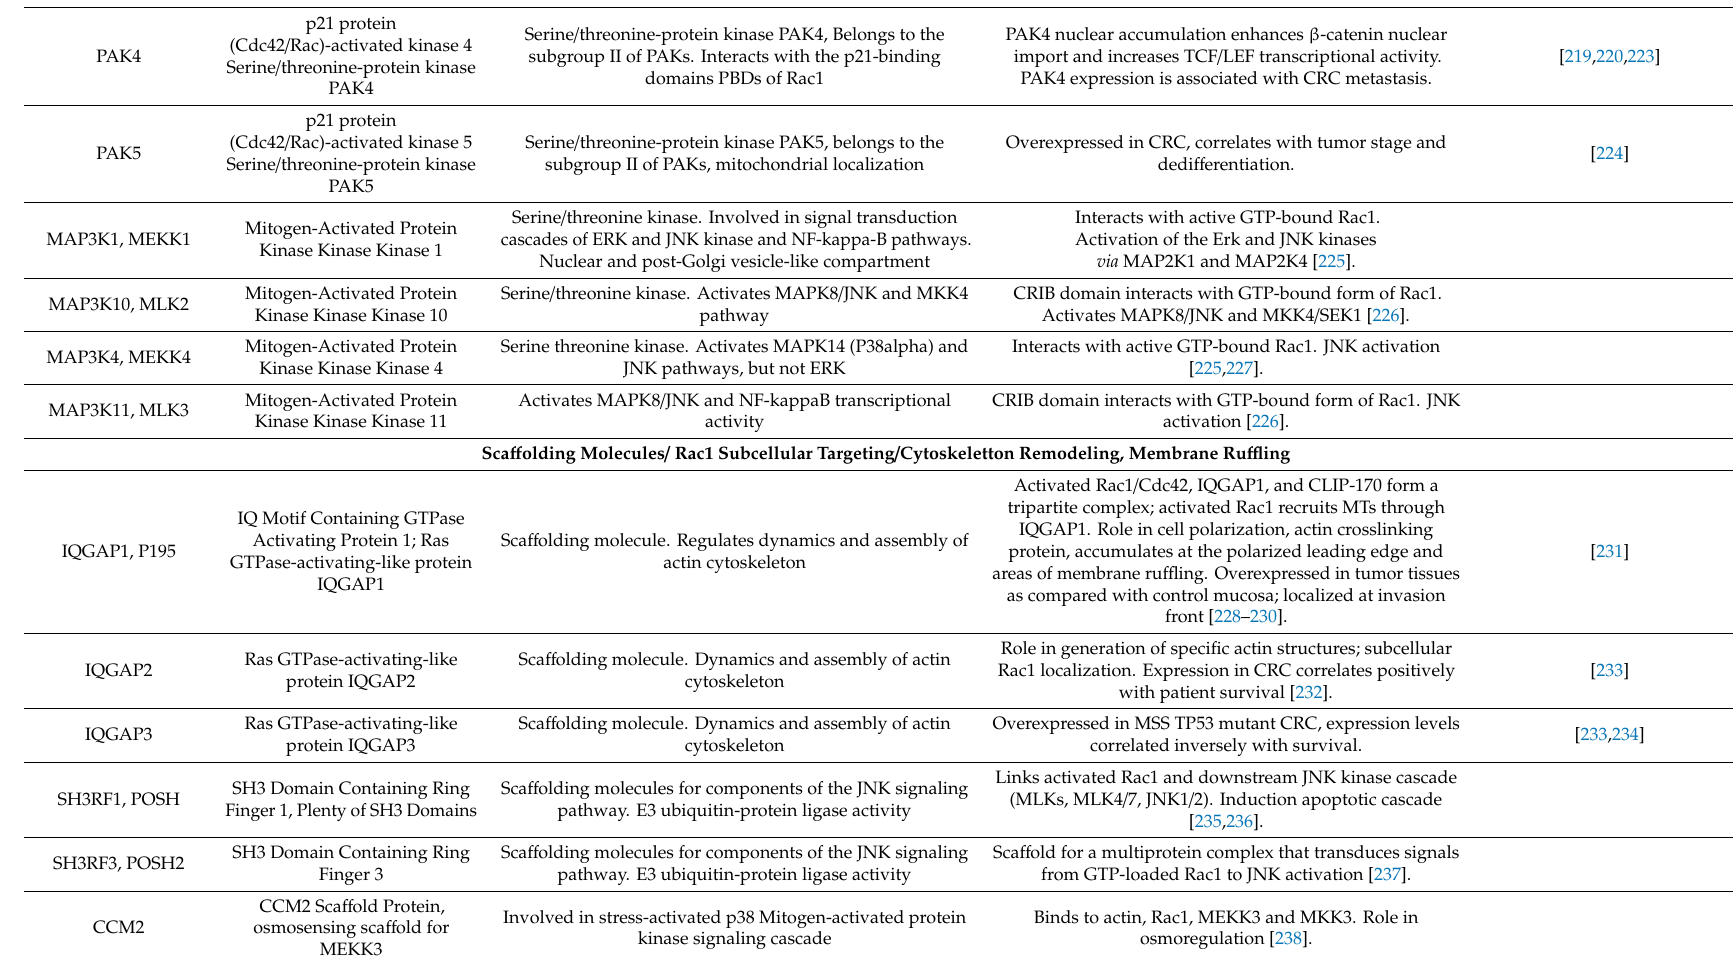
Overexpressed in CRC, correlates with tumor stage and dedi ff erentiation.